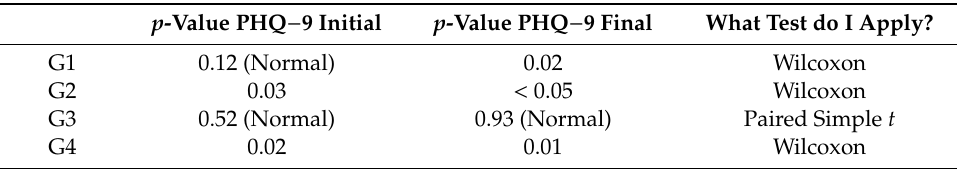
Table 4. Normality